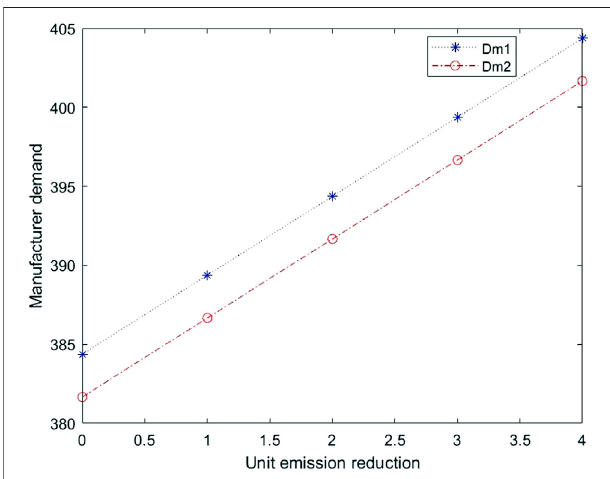
FIGURE 8 | Manufacturer demand comparison chart.